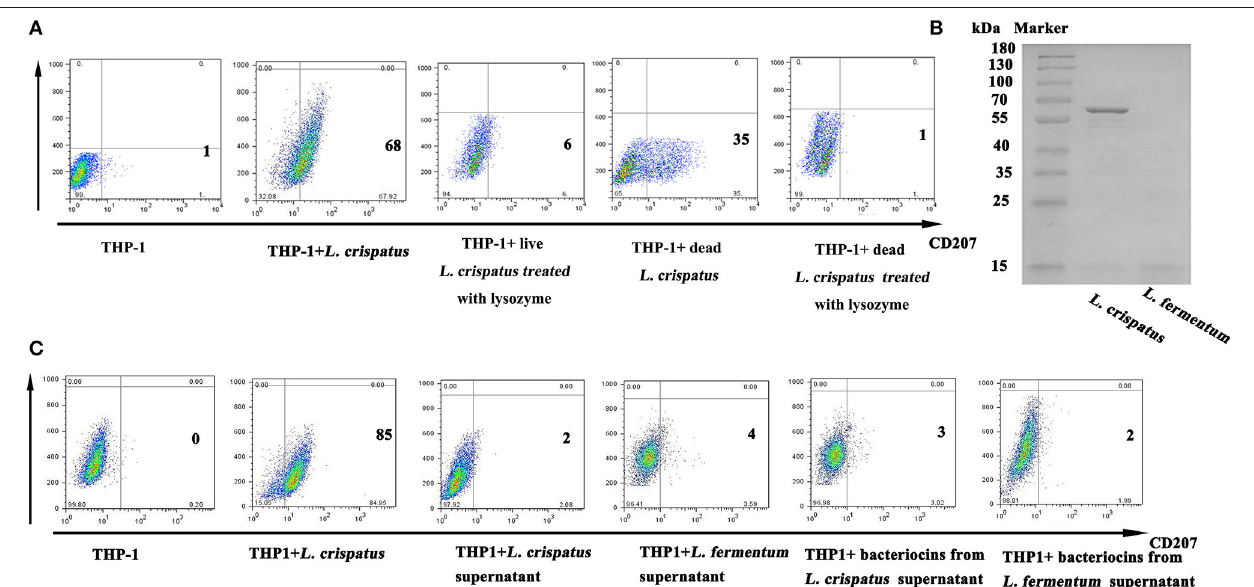
FIGURE 6 | Expression of CD207 on THP-1 cells after stimulation with lactobacilli supernatant and cell components. (A) CD207 expression induced by L. crispatus inactived with radiation or lysozyme. (B) Purification of bacteriocins from L. crispatus and L. fermentum . Bacteriocins were isolated from the MRS medium and identified by SDS-PAGE. M indicates marker. (C) CD207 expression induced by bacteriocins from L. crispatus and L. fermentum . Cells were treated with supernatant of L. crispatus and L. fermentum (2 × supernatant diluented with 2 × RPMI 1640 at the ratio 1:1) and 1 mg/ml bacteriocins from L. crispatus and L. fermentum